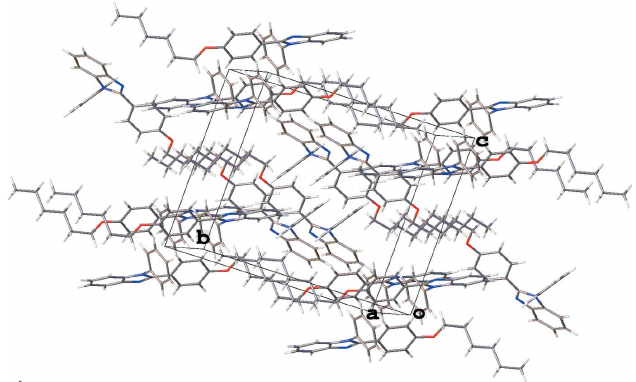
Figure 6 Fragment of the crystal packing of 2-(4-hexyloxyphenyl)-1 - phenyl-1 H- benzimidazole ( 2 ).